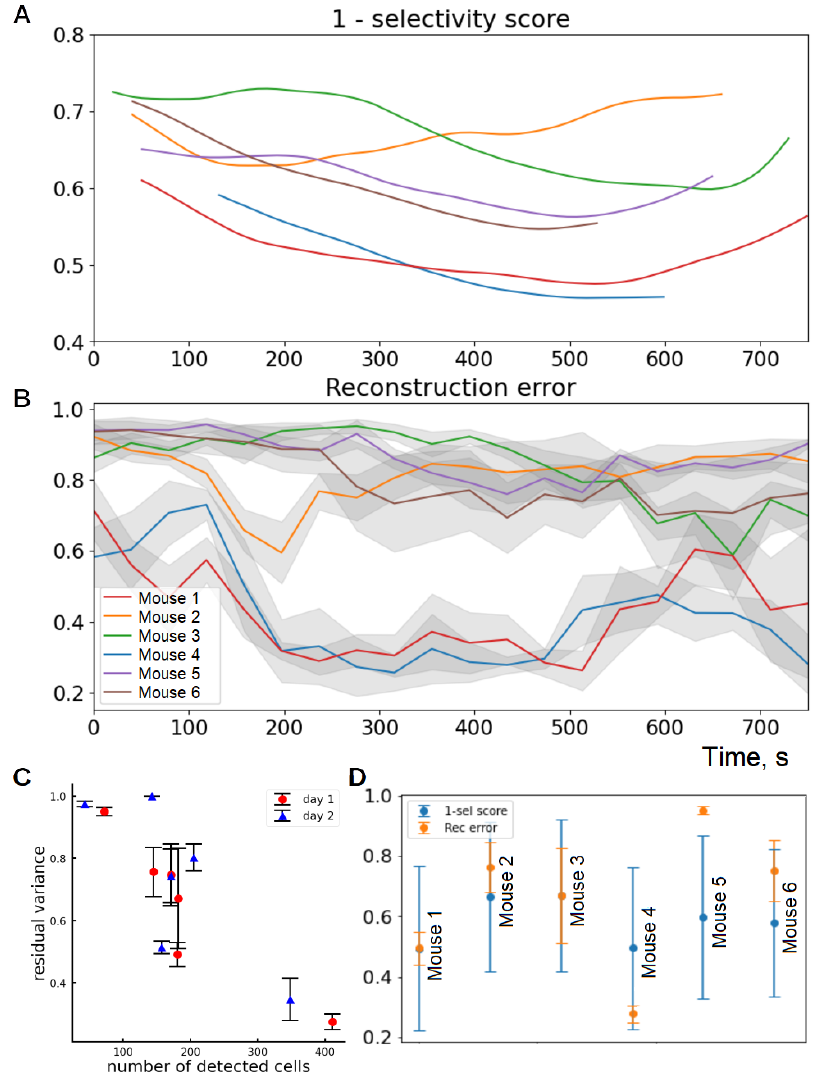
Figure 6. ( A ) Negated mean selectivity score plus one (unselectivity score), which was interpolated, smoothed with running average filter (window length 250 s) and plotted in the time domain. ( B ) Evo- lution of reconstruction error within the timeline of the 1st day session. Dimensionality reduction was performed for a sliding time window of length 250 s. Shadings represent standard deviations for LE with different graph construction parameters. NC stands for the number of cells registered. ( C ) Residual variance of the embedding depends on the number of detected cells. ( D ) Distribution of mean 1-selectivity score and of mean reconstruction error across different animals. These distributions demonstrate cosine similarity of 0.968 ±